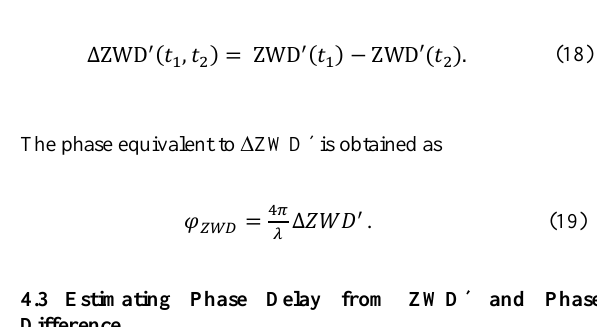
Figure 2. Estimation of ZWD ´ along slant range